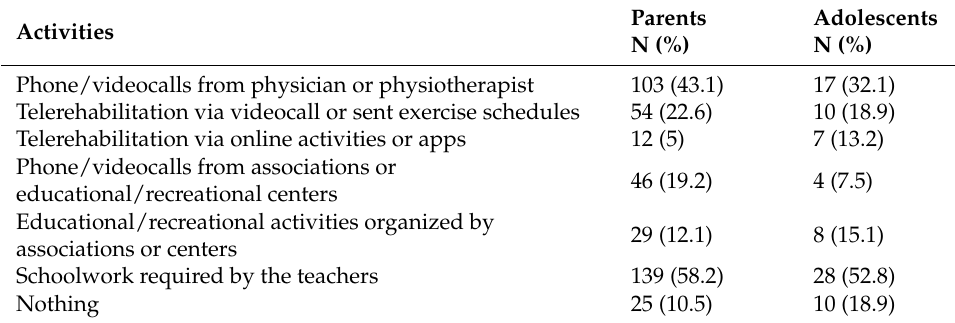
Table 6. Activities proposed during